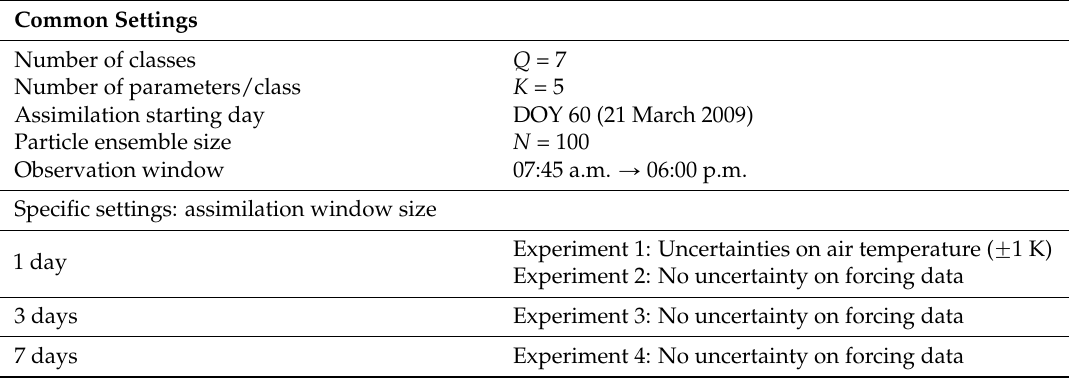
Table 2. Experimental settings for the considered